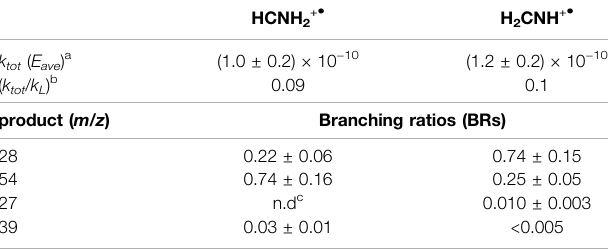
TABLE 2 | Total rate constants at fi xed average energy k tot ( E ave ) and branching ratios (BRs) for the reaction of HCNH 2+ (cid:129) and H 2 CNH + (cid:129) with C 2 H 2 . Results havebeen obtainedat E CM (cid:2) 0.08 ± 0.01 eV,correspondingtoanaverageenergy E ave (cid:2) 0.10 ± 0.01. The HCNH 2+ (cid:129) isomer was produced via dissociative photoionization of cyclopropylamine at E phot (cid:2) 12.0 eV while the H 2 CNH + (cid:129) isomer was produced by photoionization of methanimine at E phot (cid:2) 11.1